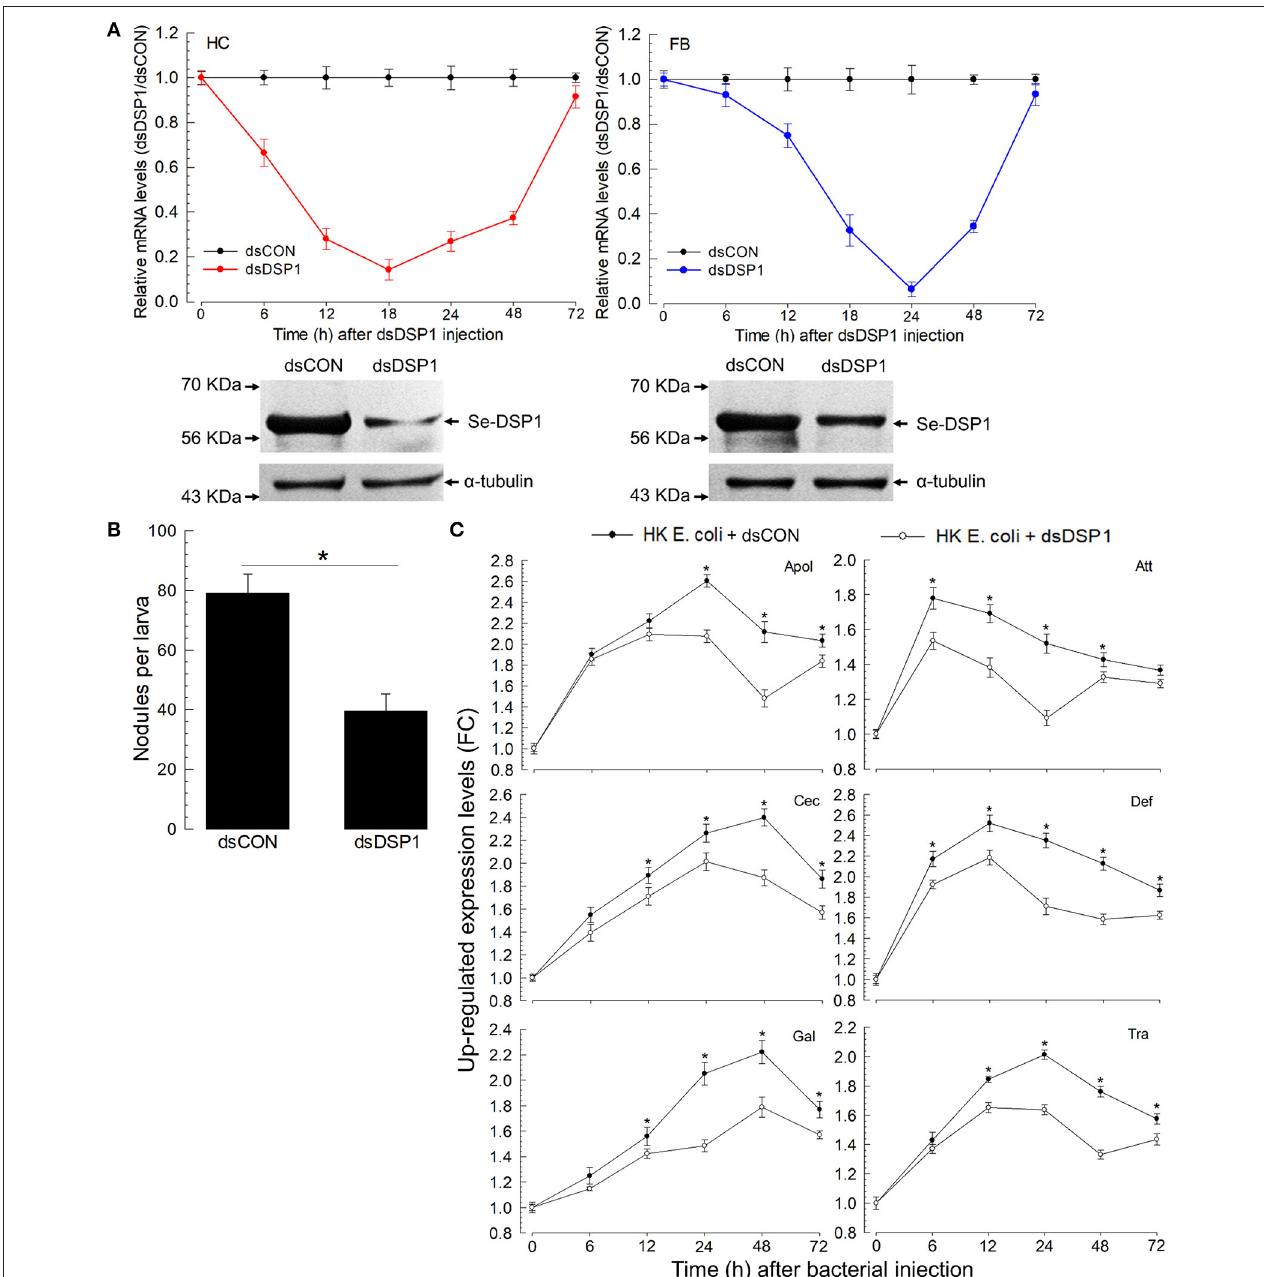
FIGURE 2 | Effects of ribonucleic acid interference (RNAi) on Se-DSP1 expression and immune responses of S. exigua . (A) The temporal change of Se-DSP1 expression level after the treatment of L5 larvae with double-stranded (ds)RNA specific to Se-DSP1 (1 µ g per larva). A viral gene, CpBV302 , was used as a control dsRNA (“dsCON”). The lower panels indicate Western blotting against HC and FB extracts. A homogenous immunoblotting intensity against α -tubulin indicates the equal amount of protein sample loading in each lane. (B) The suppression of hemocyte nodule formation. For the bacterial challenge, HK E. coli (4.5 × 10 4 cells per larva) were injected into each larva 24h after dsRNA treatment. At 8h PI, the number of nodules was assessed. (C) The suppression of six AMP gene expressions after RNAi treatment. A ribosomal protein, RL32, was used as an internal control. Relative expression levels were determined by normalization compared with the levels of the control gene expression followed by the calculation of relative ratios compared with the lowest level. Each treatment was replicated three times. Asterisks above SD bars indicate a significant difference among means at Type I error = 0.05 (least significant difference, LSD, test). G-100 (Sigma-Aldrich, Seoul, Korea) ( Figure 4A ). During the purified using an affinity chromatography system containing purification of the full-length Se-DSP1, a partial protein was nickel-nitrilotriacetic acid (Ni-NTA) resin and further cleared also purified and confirmed by a Western analysis against a with a gel filtration chromatography system containing Sephadex